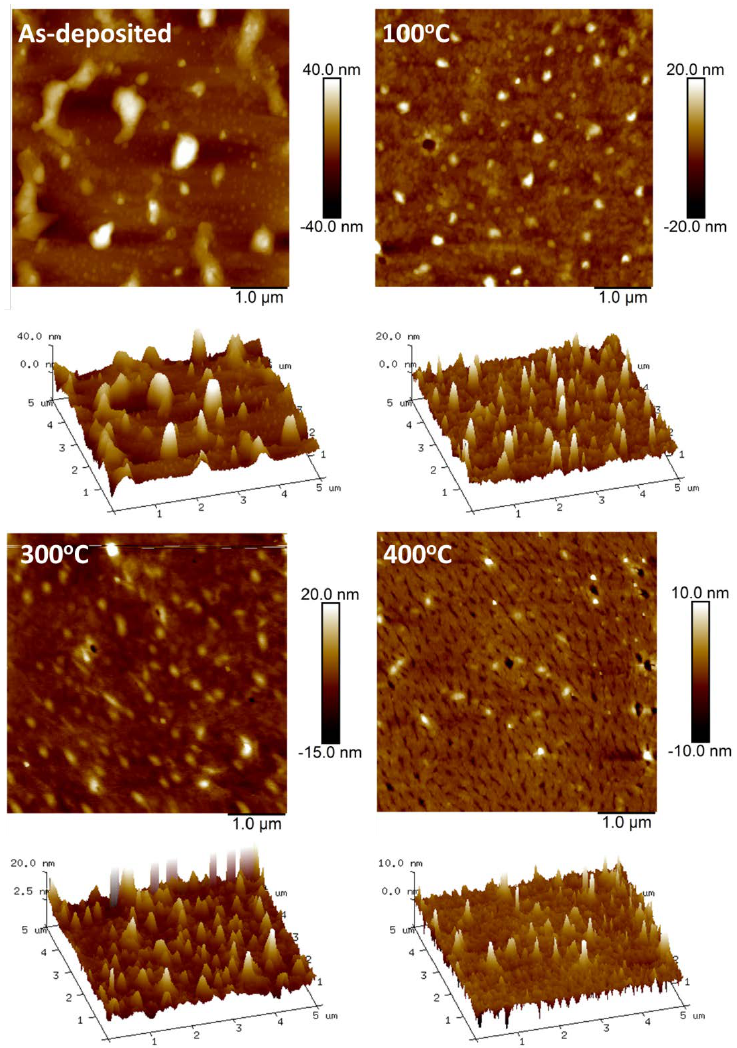
Figure 2. Atomic force microscope (AFM) images of fluorinated chromium phthalocyanine (FCrPc) deposited and treated with different temperatures.